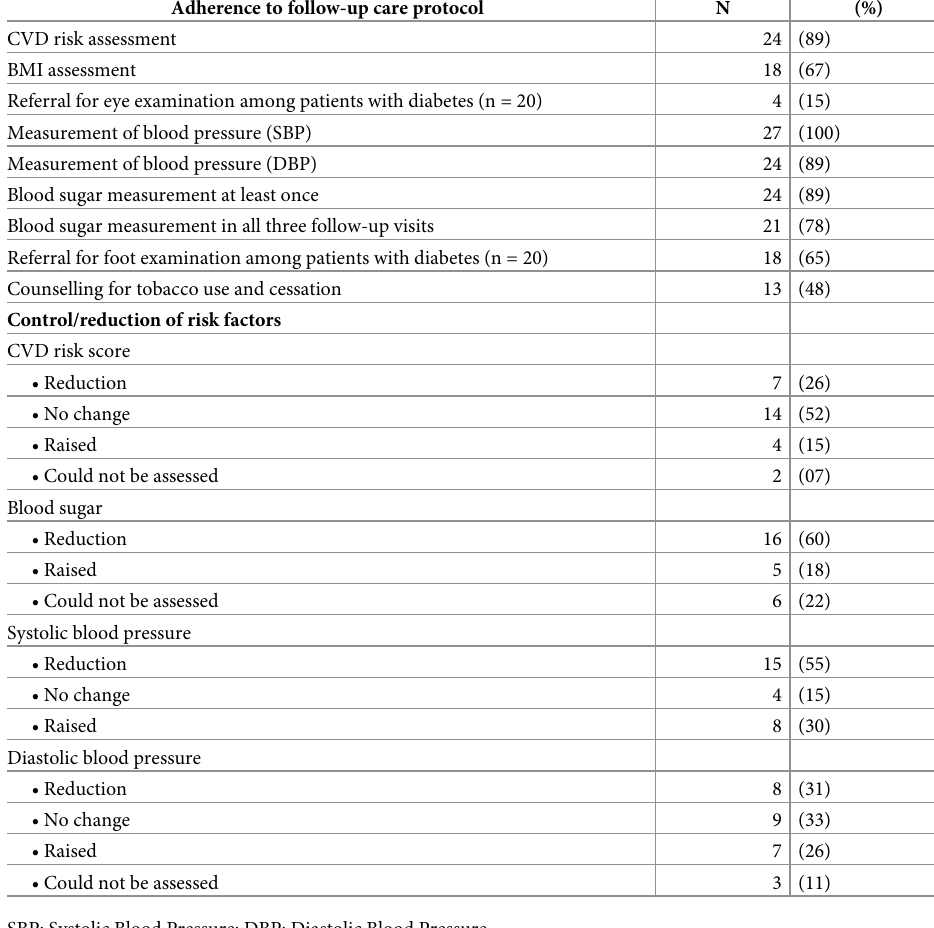
Table 3. Adherence � to follow up protocol and control/reduction of risk factors in the third follow up visit com- pared to the first visit among those with at least 3 follow up visits (n = 27). Adherence to follow-up care protocol N CVD risk